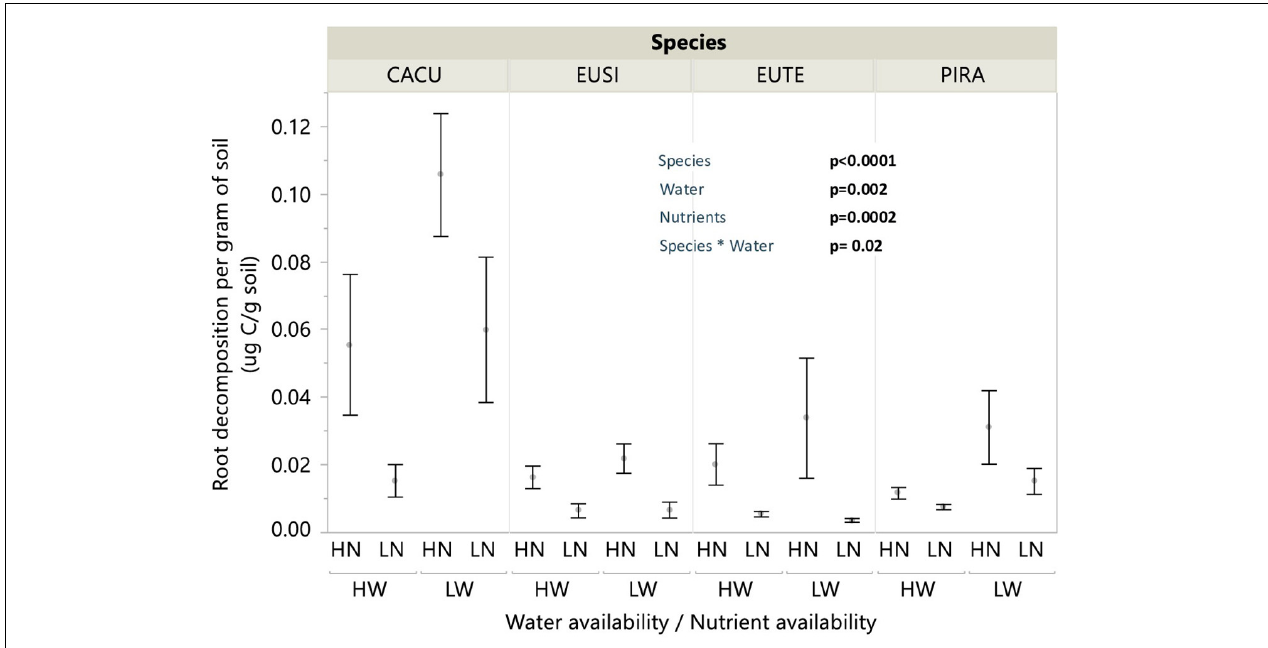
FIGURE 5 | Integrated impact of changes belowground on C release from root decomposition in response to water and nutrient availability treatments N. Values are root decomposition per gram of root applied to the total root biomass per gram of soil. Water (W), Low/High water availability (HW, LW); Nutrients (N), Low/High nutrient availability (LN, HN). Data points represent averages across shelters/replicates with standard error ( n = 6). P -values are from significant effects from three-way ANOVA (Water, Nutrients, Species) with interactions. CACU, Casuarina cunninghamiana ; EUSI, Eucalyptus sideroxylon ; EUTE , Eucalyptus tereticornis ; PIRA, Pinus radiata